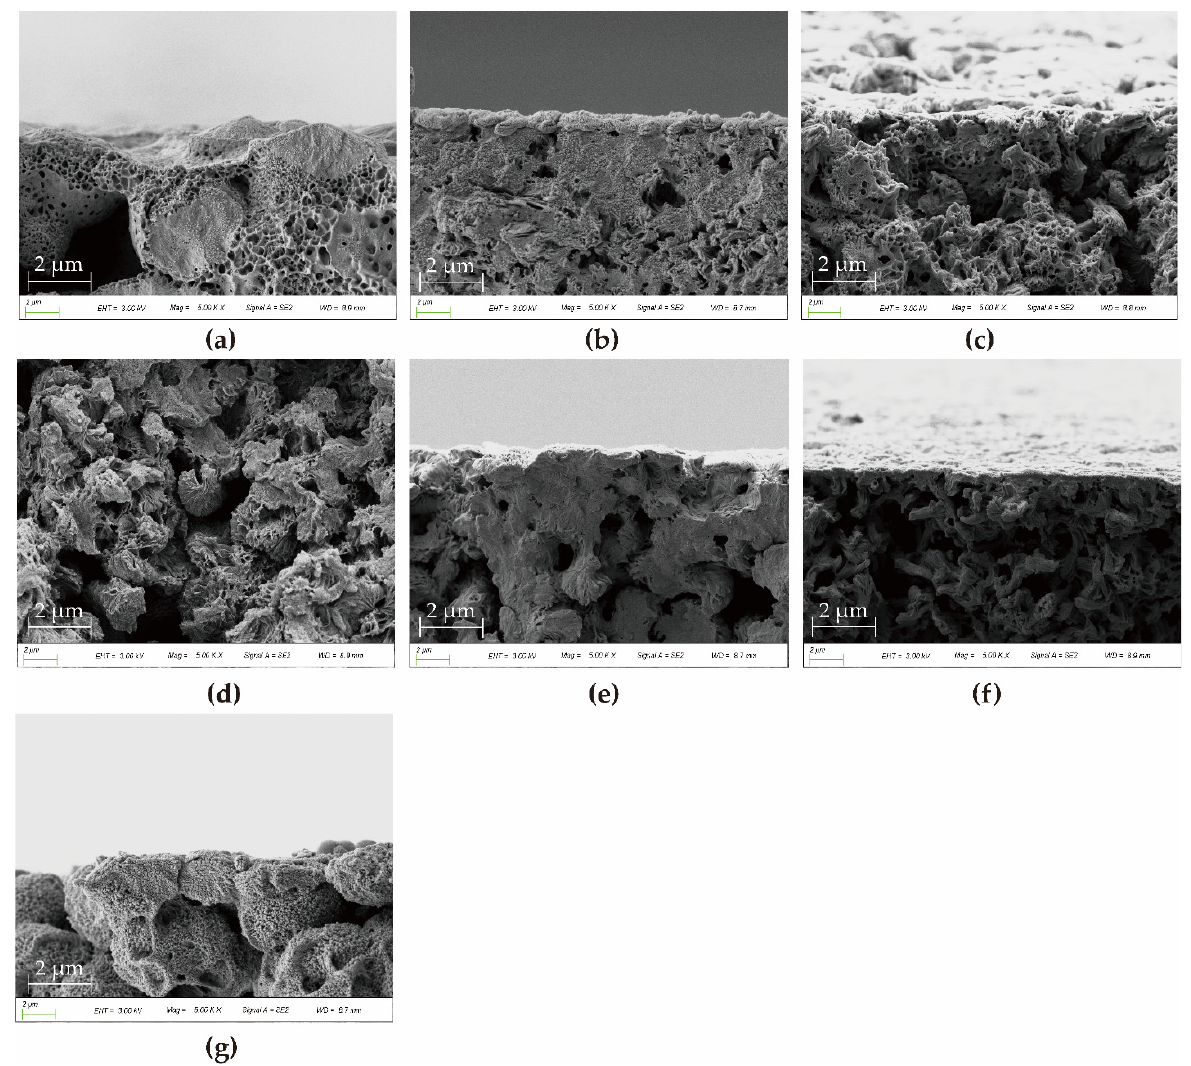
Figure 6. SEM images of cross-section of various PA66 membranes: ( a ) P0, ( b ) P1, ( c ) P2, ( d ) P3, ( e ) P4, ( f ) P5 and ( g ) P6.